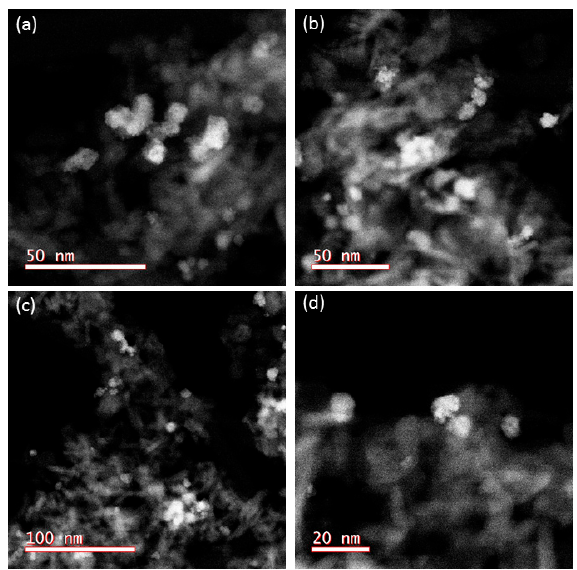
Figure 6. ( a – d ) Low-magnification HAADF STEM images show the PdO/PdO x distributed in γ -Al 2 O 3